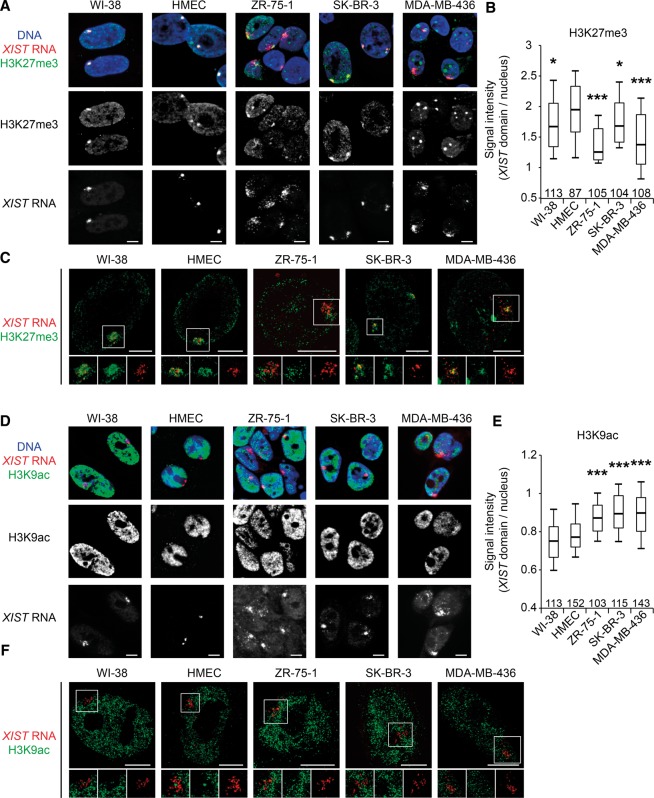
H3K27me3 and H3K9ac profiles associated with XIST-coated X chromosomes are impaired in breast cancer cell lines. (A) Z-projections of 3D immuno-RNA FISH show representative examples of the level of H3K27me3 enrichment (green) on XIST RNA domains (red) in normal (WI-38 and HMEC) and breast cancer cell lines (ZR-75-1, SK-BR-3, and MDA-MB-436). NB: In MDA-MB-436, the highly H3K27me3 enriched bodies visible in each nucleus do not belong to the X chromosome (nor in metaphase [Fig. 3C] or in interphase [Supplemental Fig. S3F]). (B) Boxplot shows the levels of H3K27me3 enrichment on XIST domains relative to the rest of the nucleus. Numbers of analyzed nuclei are shown above the x-axis. For details on quantification method see Supplemental Figure S2A,B. (C) High-resolution immuno-RNA FISH shows representative examples of H3K27me3 enrichment (green) on XIST RNA domains (red) in normal and breast cancer cell lines. Insets for H3K27me3, XIST RNA, and merge are shown below each cell line. (D) Single section of 3D immuno-RNA FISH shows representative examples of the level of H3K9ac depletion (green) on XIST RNA domains (red) in normal and breast cancer cell lines. (E) Boxplot shows the levels of H3K9ac depletion on XIST domains relative to the rest of the nucleus. The numbers of analyzed nuclei are shown above the x-axis. For details on the quantification method, see Supplemental Figure S2A,C. (F) High-resolution immuno-RNA FISH shows representative examples of H3K9ac depletion (green) on XIST RNA domains (red) in normal and breast cancer cell lines. Insets for H3K9ac, XIST RNA, and merge are shown below each cell line. (Boxplots) Upper whisker represents 90%, upper quartile 75%, median 50%, lower quartile 25%, and lower whisker 10% of the data set for each cell line. (***) P < 0.001; (**) P < 0.01; (*) P < 0.05 using the Student's t-test. All data sets are compared with HMEC data set. Scale bar, 5 µm.